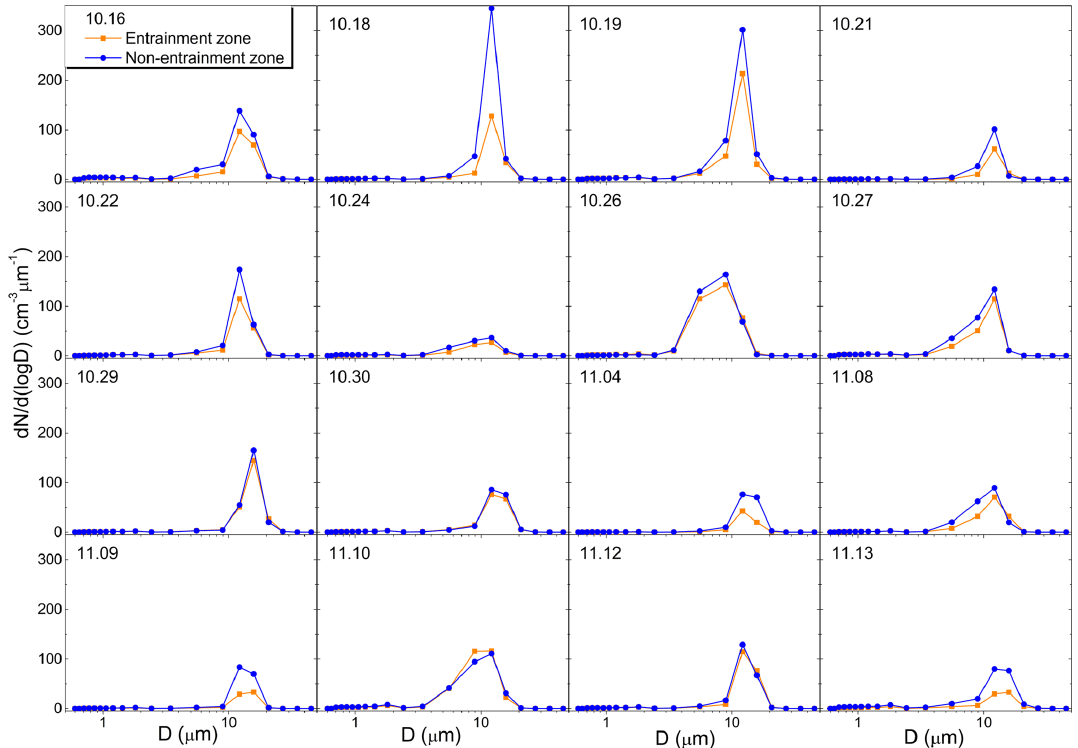
Figure 11. Number size distributions of cloud droplets in the entrainment (orange) and non-entrainment zones (blue) during all 16 non- drizzling flights.